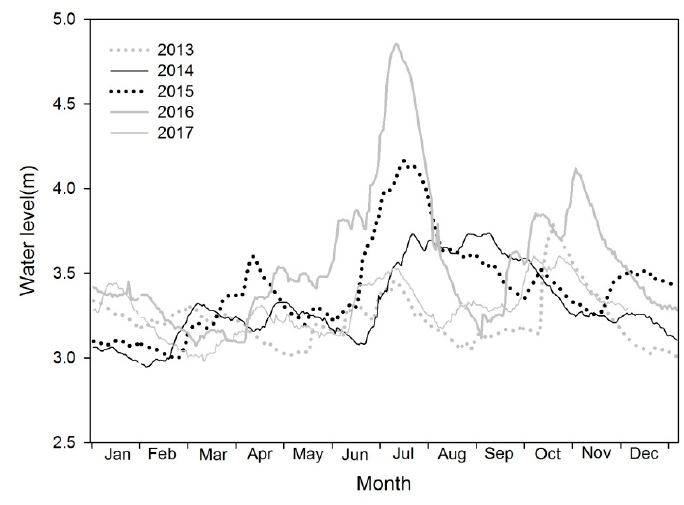
Figure 3. Monthly comparison of daily water levels of Lake Taihu from 2013 to 2017.